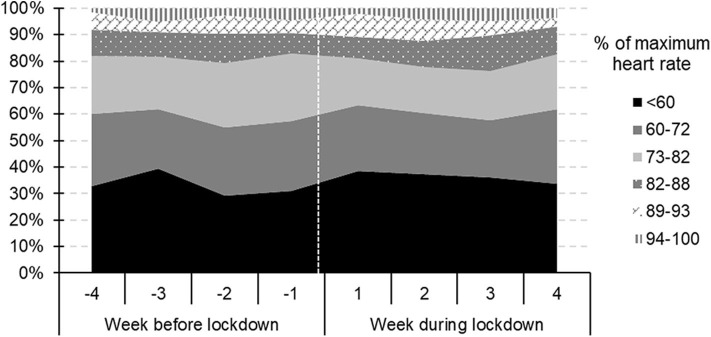
The proportions of the total training time each week spent in the different intensity zones during the 4-week periods prior to and at the beginning of the lockdown.